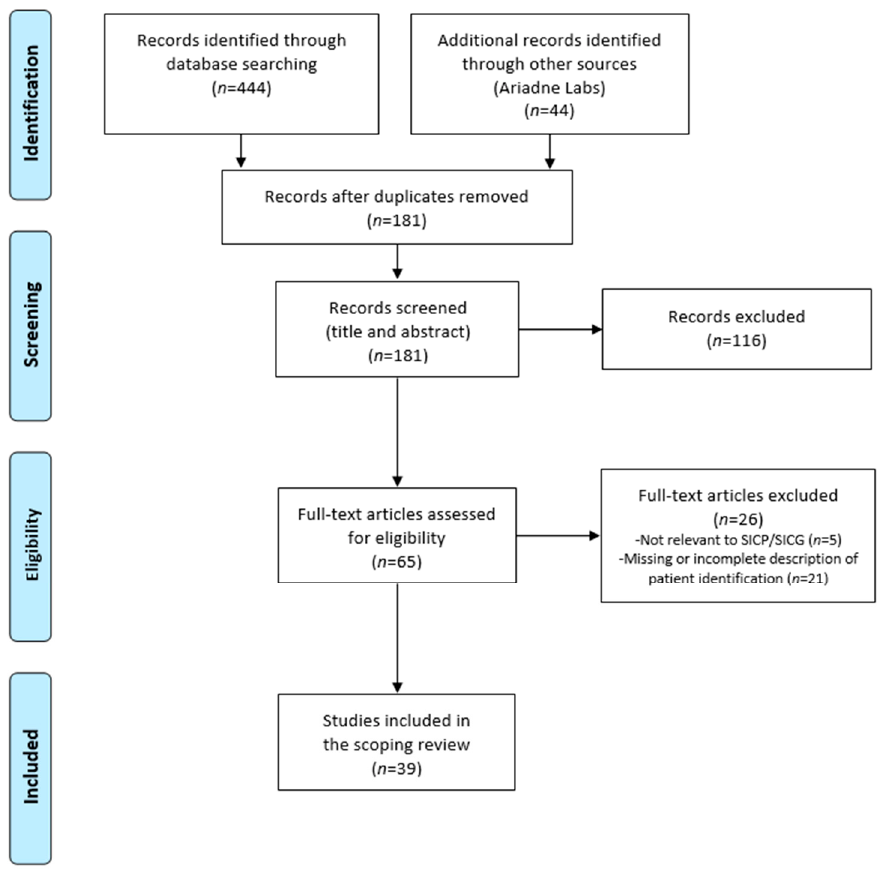
Figure 1. Summary of study selection process—PRISMA-ScR.